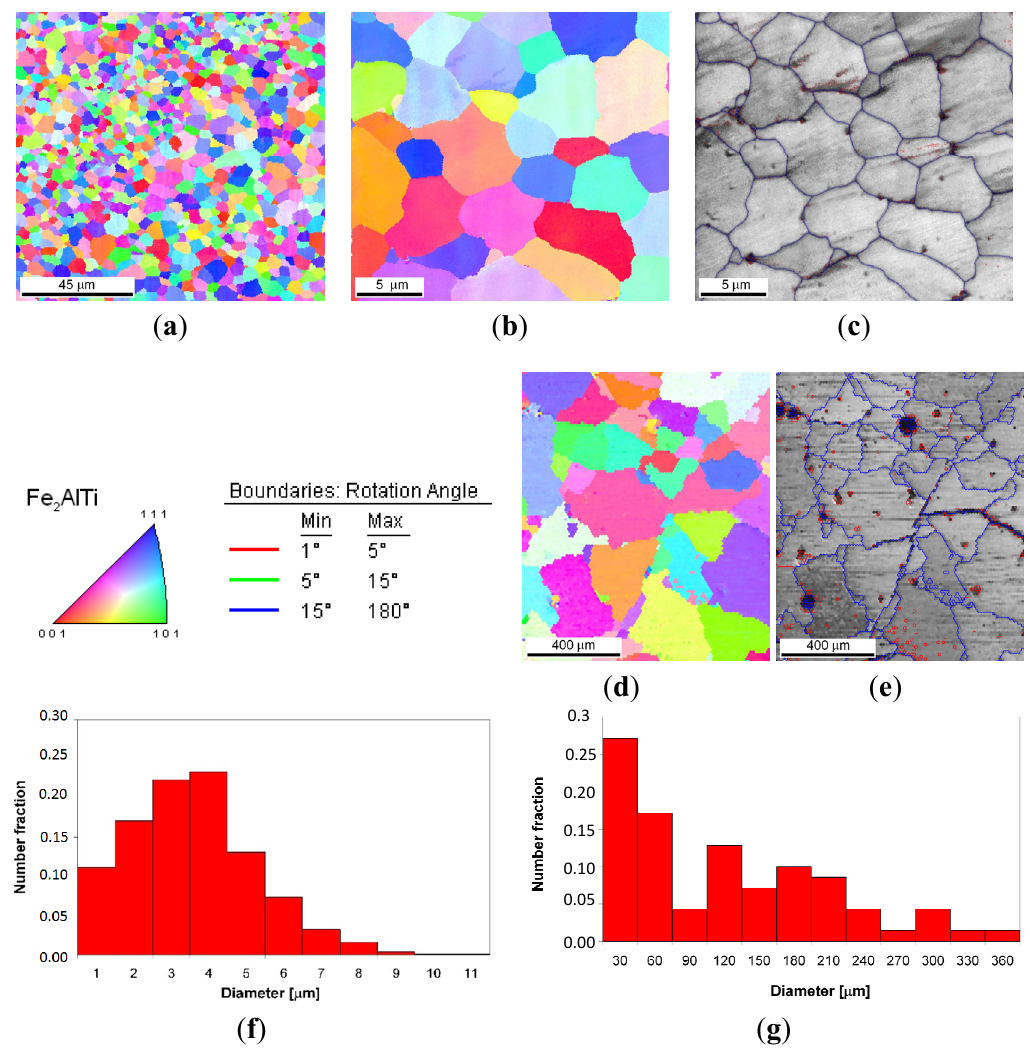
Figure 10. The OIM microstructural characterization of sample no. 3: ( a , b ) orientation and ( c ) boundary maps after laser deposition; ( d ) orientation and ( e ) boundary maps after laser deposition and annealing; ( f ) grain size distribution of L2 1 Fe 2 TiAl phase; ( g ) grain size distribution of C14 Fe 2 Ti Laves phase. Color coded stereographic triangle is provided for orientation maps ( a , b , d ) and grain boundary rotation angle scale for grain boundary representation ( e